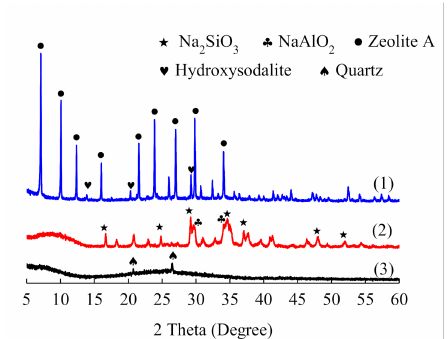
Figure 2. XRD pattern of coal gasification fine slag (CGFS), solid-phase molten product, and synthetic zeolite A. (1) Zeolite A, (2) fusion product, and (3) CGFS.